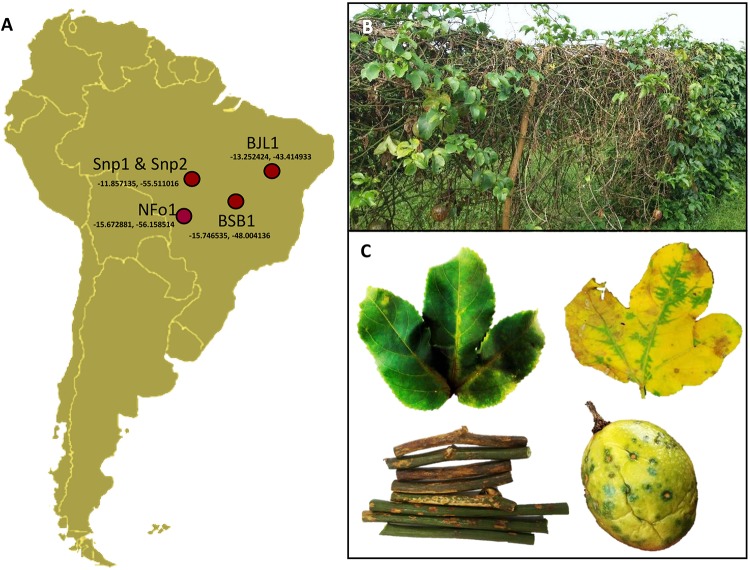
Symptoms of passion fruit green spot virus (PfGSV)-infected passion fruit plants. (A) Samples of diseased passion fruit plants (Passiflora spp.) were collected in four regions of Brazil. (B) Overview of a PfGSV-affected orchard in Sinop, MT, Brazil. (C) Details of chlorotic and necrotic symptoms on leaves, stems, and fruits. Note the yellow strips along the veins in green young leaves (left) that turn green areas in a yellow background covering the non-infected areas in the oldest leaves (right).